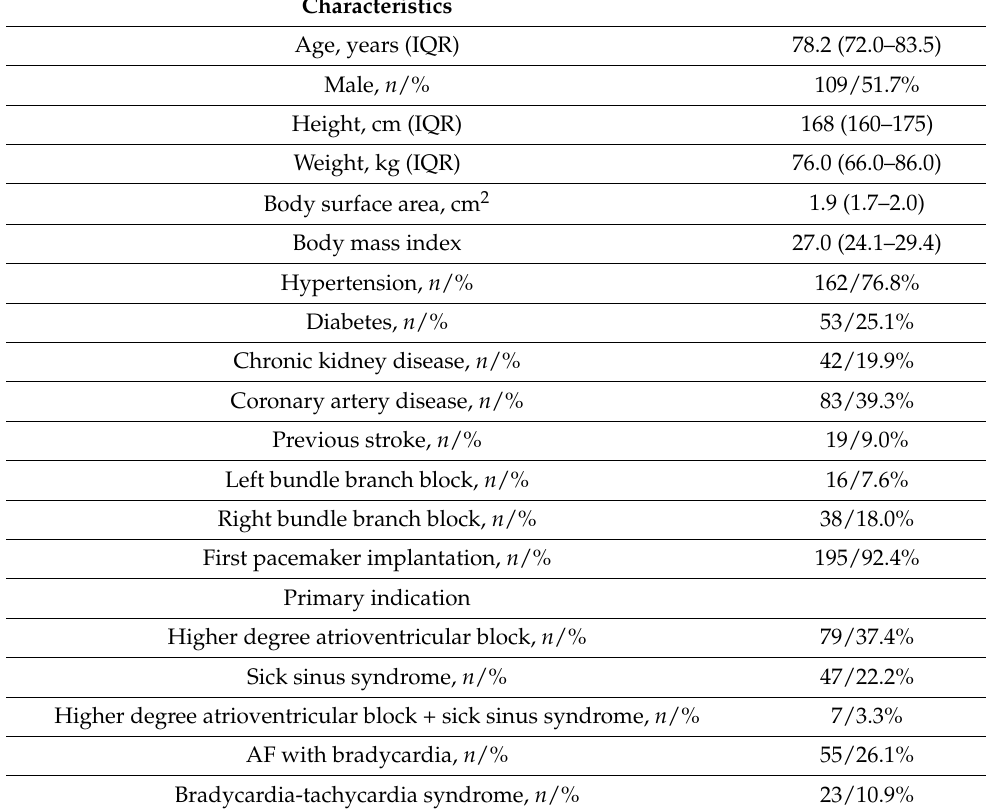
Table 1. Baseline